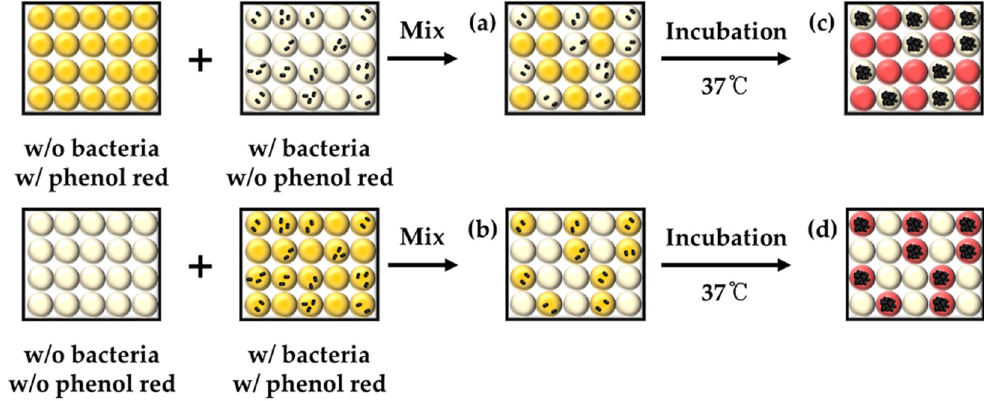
Figure 8. Schematic diagram of crosstalk between mixed droplets. Two types of droplets were mixed and incubated for identifying the gas crosstalk.